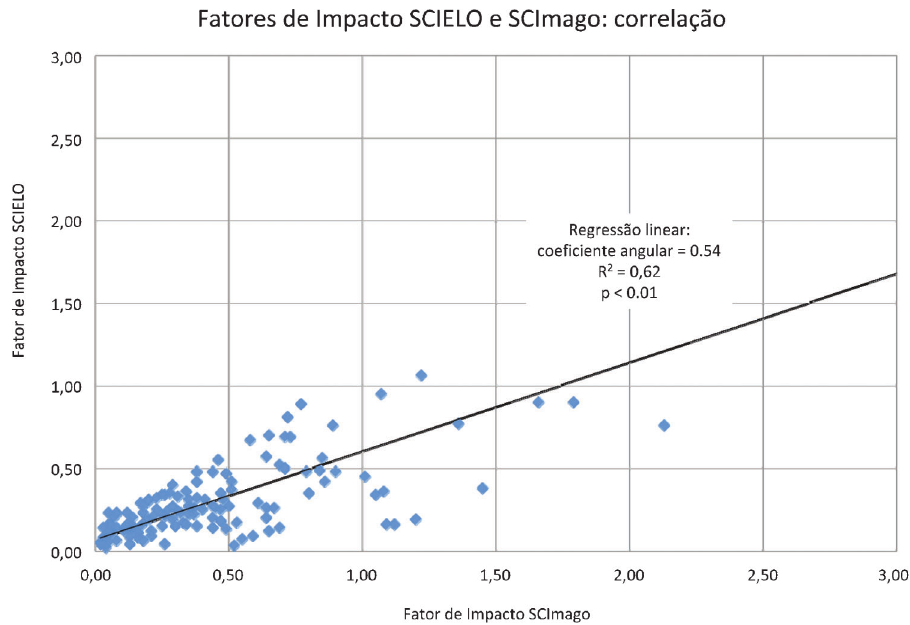
Figura 3 - Correlac¸a˜o entre fatores do impacto SciELO e SCImago (2009) para 142 perio´dicos brasileiros representados nos dois ı´ndices com valor maior que zero. O coeficiente angular indica um angulo de 28 ˚ e um impacto SciELO me´dio 40% menor que o SCImago.